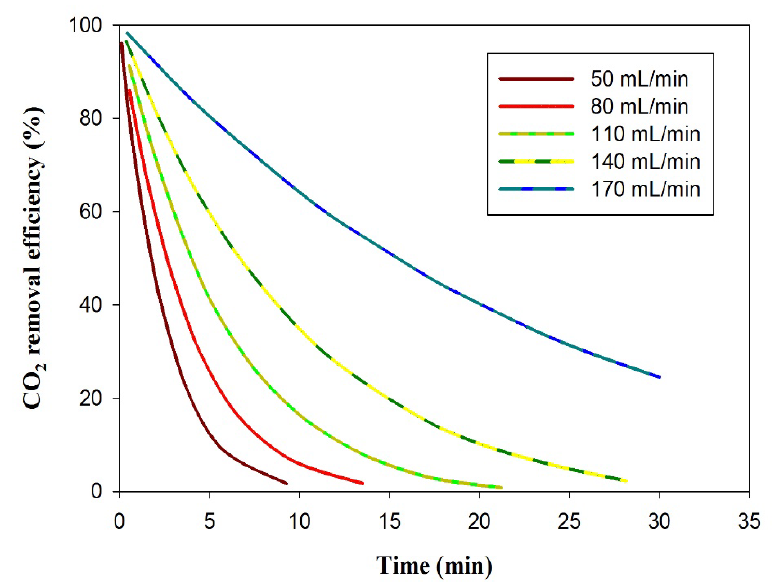
Figure 4. E ff ect of solvent initial feed rate (50, 80, 110, 140, and 70 mL / min) at constant gas feed rate Figure 4. Effect of solvent initial feed rate (50, 80, 110, 140, and 70 mL/min) at constant gas feed rate (10 mL / min) on the CO 2 removal e ffi ciency with time. (10 mL/min) on the CO 2 removal efficiency with time.